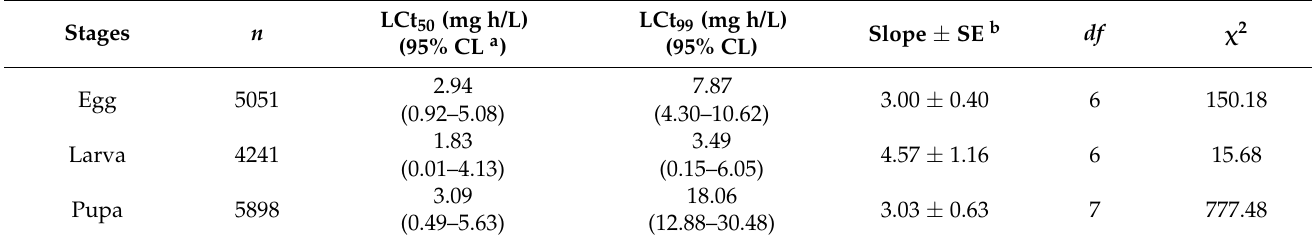
Table 3. Lethal concentration time for D. suzukii exposed to successive application of methyl bromide and cold treatment for 1 d.